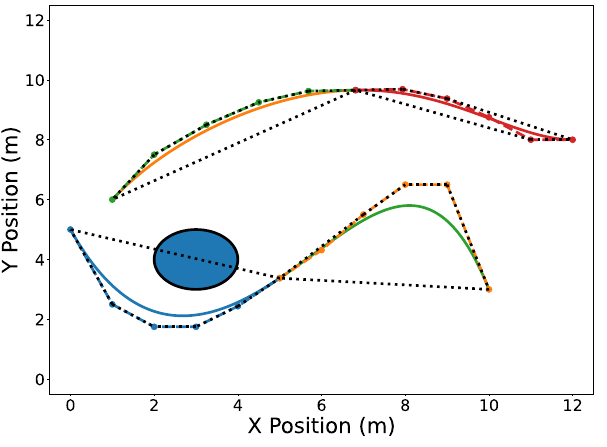
Figure 3. Convex hulls drawn as black dotted lines around the Bernstein coefficients of trajectories C [ 1 ] ( t ) (blue) and C [ 2 ] ( t ) (orange). The dashed lines connect the control points of their correspond- ing trajectories.